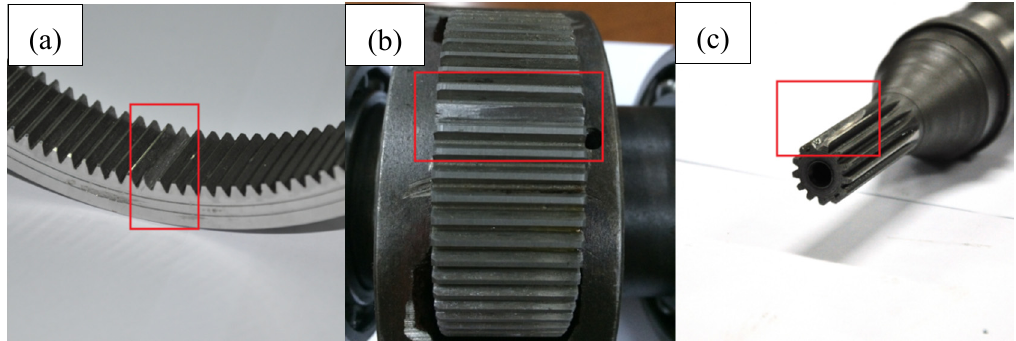
Figure 20. Implanted wear fault: ( a ) ring gear; ( b ) planet gear; ( c ) sun gear.